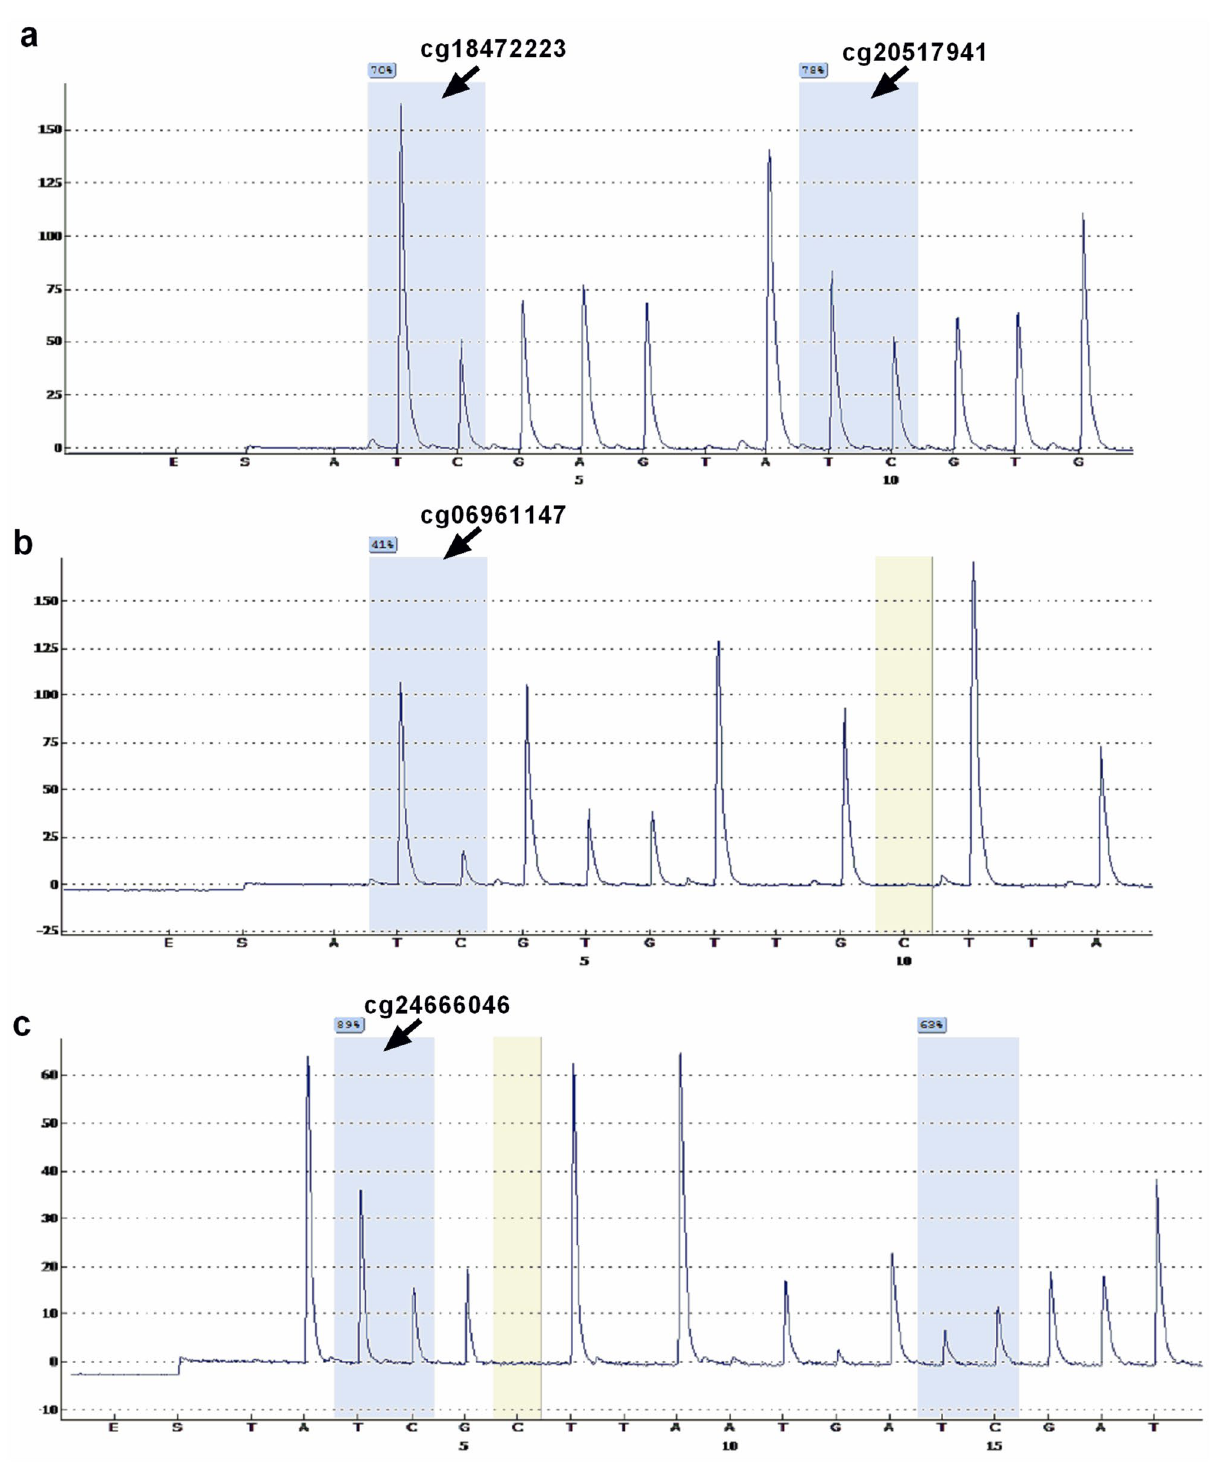
Figure 6. Representative images of pyrosequencing for four differentially methylated loci in one patient. Images of pyrosequencing were generated for cg18472223 and cg20517941 (a) , cg06961147 (b) , and cg24666046